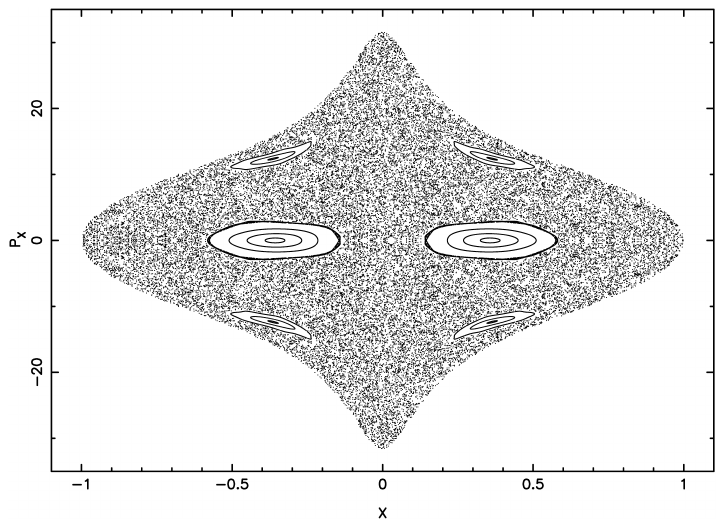
Fig. 7. Similar to Figure 1, but for c n = 0 : 10 and h 2 = 0 :